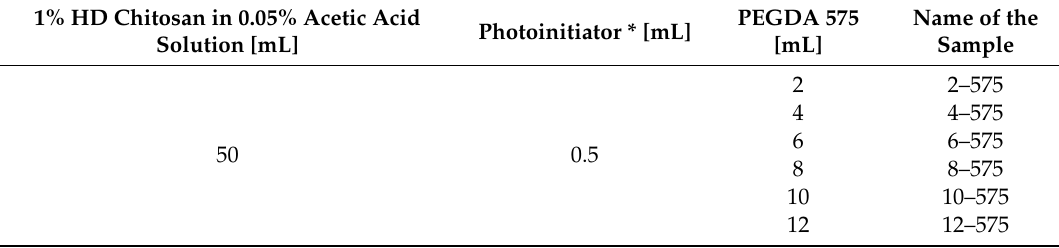
Table 1. Compositions of hydrogels prepared using PEGDA 575 as a crosslinking agent.